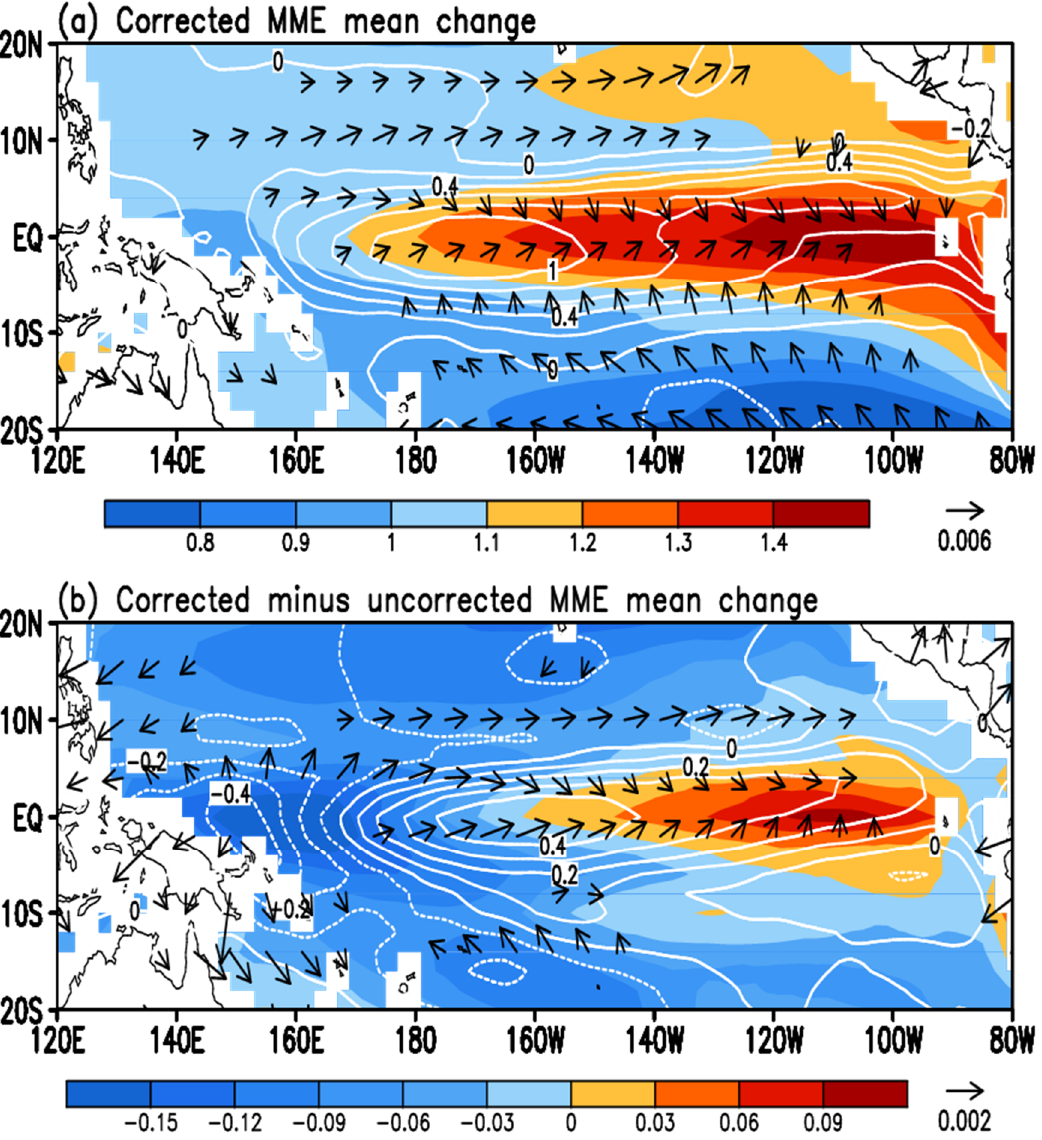
Figure 8. ( a ) Same as Figure 6a, except for the corrected MME mean changes using an observational constraint of equatorial western Pacific precipitation. ( b ) Corrected-minus-uncorrected differences in MME mean changes.